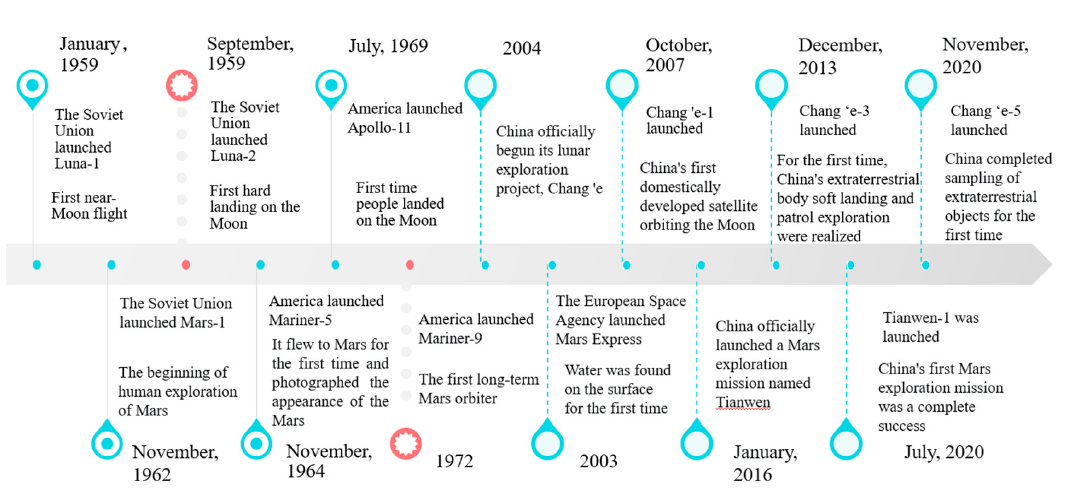
Figure 7. The exploration processes of the Moon ( above ) and Mars ( below ).